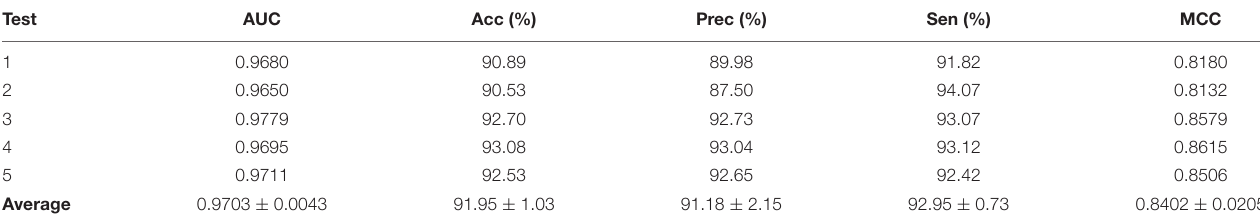
TABLE 5 | Results of the proposed model in channel–drug interaction dataset.